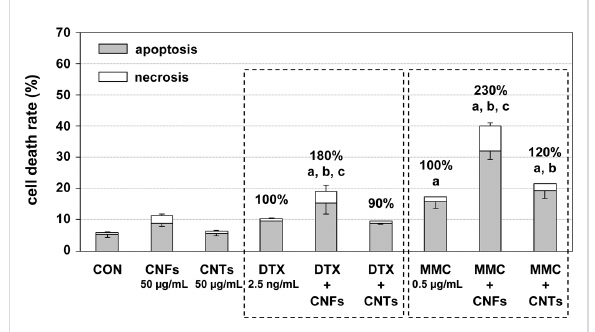
Figure 3: Cell death rate of DU-145 cells following treatment with car- bon nanomaterials and chemotherapeutics alone or in combination. Combinatory treatments contained the respective carbon nanomateri- al and chemotherapeutic in the same concentrations as indicated for the individual treatments. Averaged fractions of dead cells (%) due to apoptosis and necrosis ± mean deviation are depicted. Untreated cells (CON) served as control treatment. a p < 0.05 treatment versus control; b p < 0.05 treatment versus carbon nanomaterial alone, c p < 0.05 treat- ment versus chemotherapeutic alone.